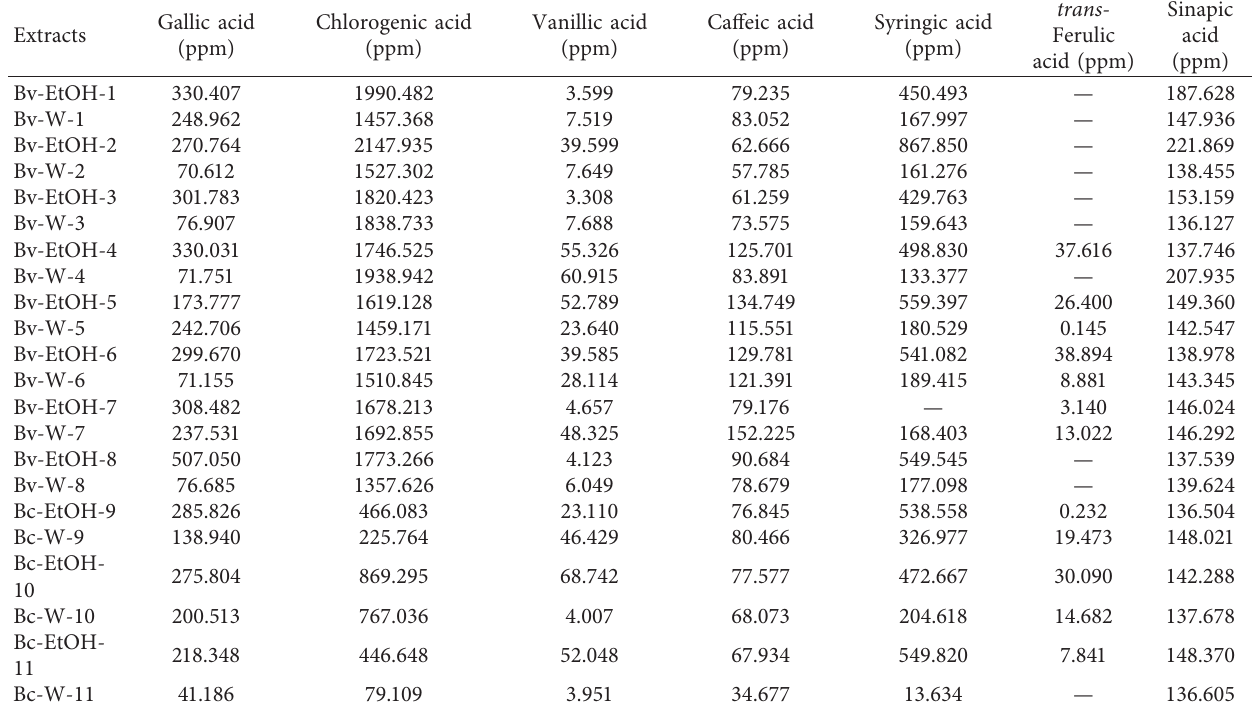
Table 4: Phenolic component concentrations of alcohol and water